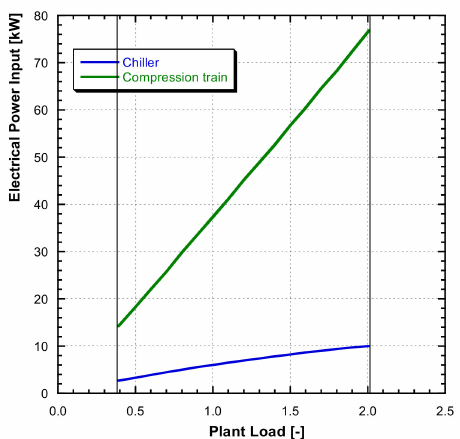
Figure 6. Non dimensional electric energy consumption of compressors and chiller as a function of the total electrical